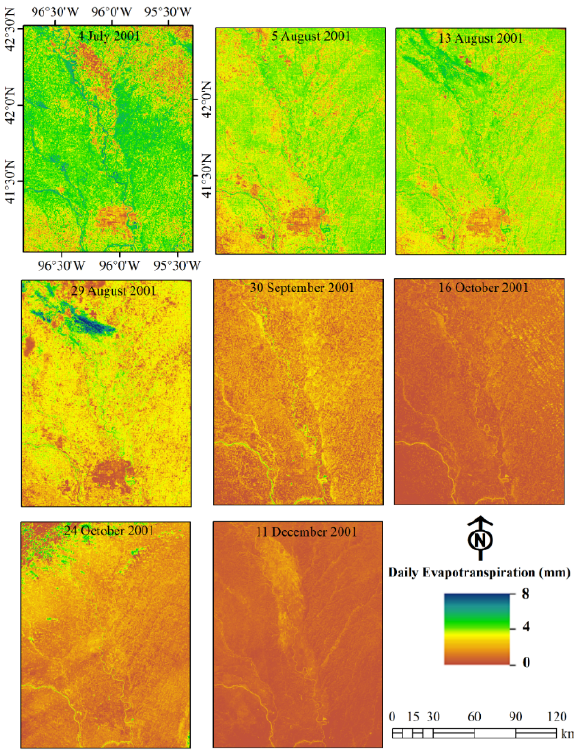
Figure 4. Daily evapotranspiration map for the days of satellite overpasses based on the Surface Energy Balance System (SEBS) model.